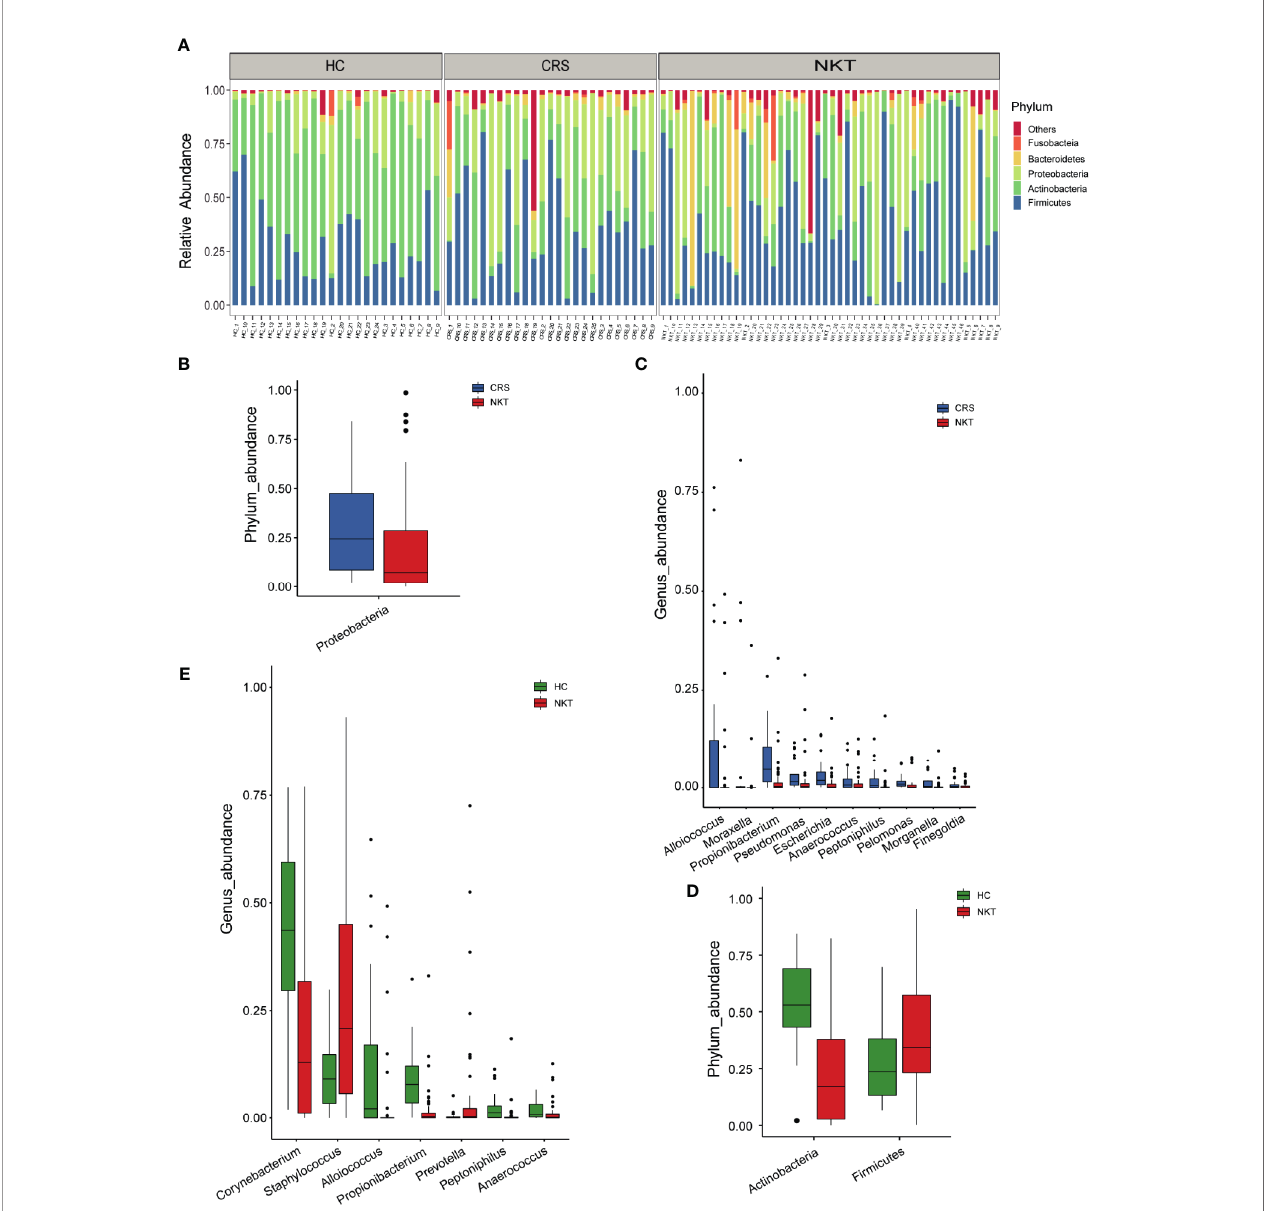
FIGURE 2 | Phylogenetic features of nasal microbiota among patients with NKTCL (n = 46), patients with CRS (n = 25) and HCs (n = 24). Only phyla or genera with relative abundances > 0.5% are shown. (A) The bacterial phylum composition of each specimen (n = 95). The signi fi cantly depleted microbial community members at the (B) phylum level and (C) genus level in the NKT group versus the CRS group. The signi fi cantly differentially abundant microbial community members at the (D) phylum level and (E) genus level in the NKT group versus the HC group. The box presents the 95% CI; the line inside denotes the median. NKT, natural killer/T cell lymphoma; CRS, chronic rhinosinusitis; HC, healthy